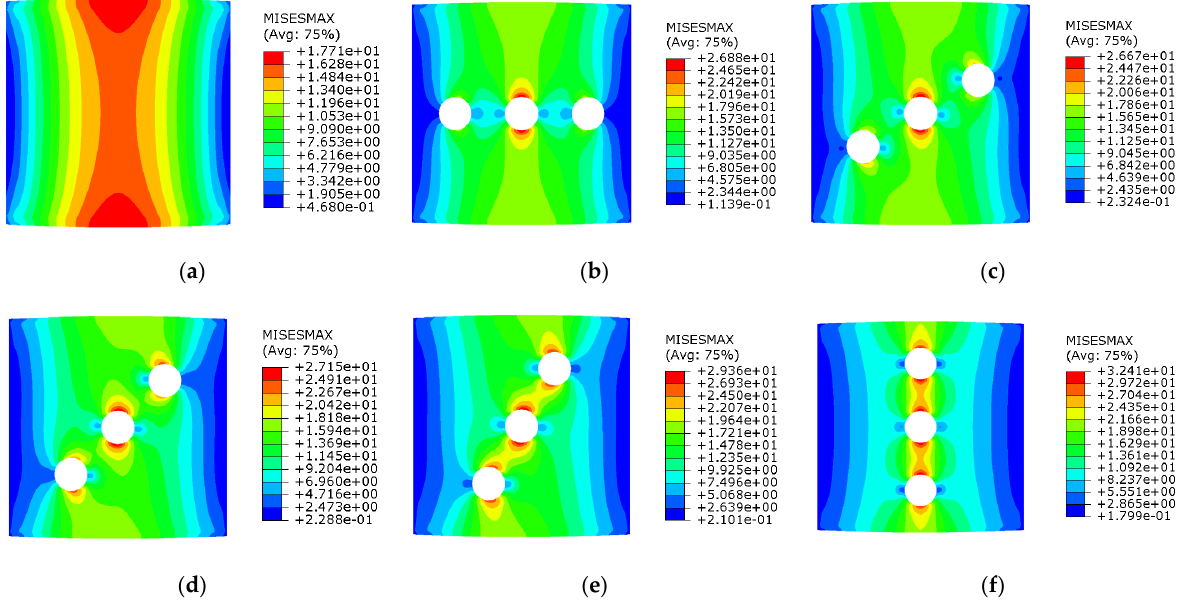
Figure 6. Von Mises stress of FGM plates with ( a ) a plate thickness of 50 mm, a cutout diameter of 300 mm with an arrangement of ( b ) 0 ° , ( c ) 30 ° , ( d ) 45 ° , ( e ) 60 °, and ( f ) 90 °.